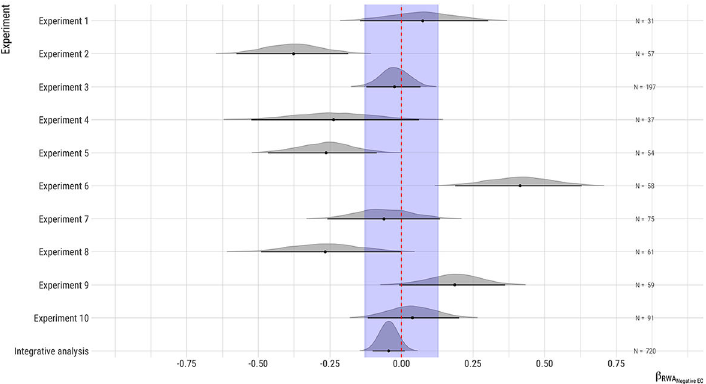
Note. The purple area corresponds to a region of practical equivalence where the values are considered equivalent to 0 (Kruschke, 2018). More information can be found in the Supplementary